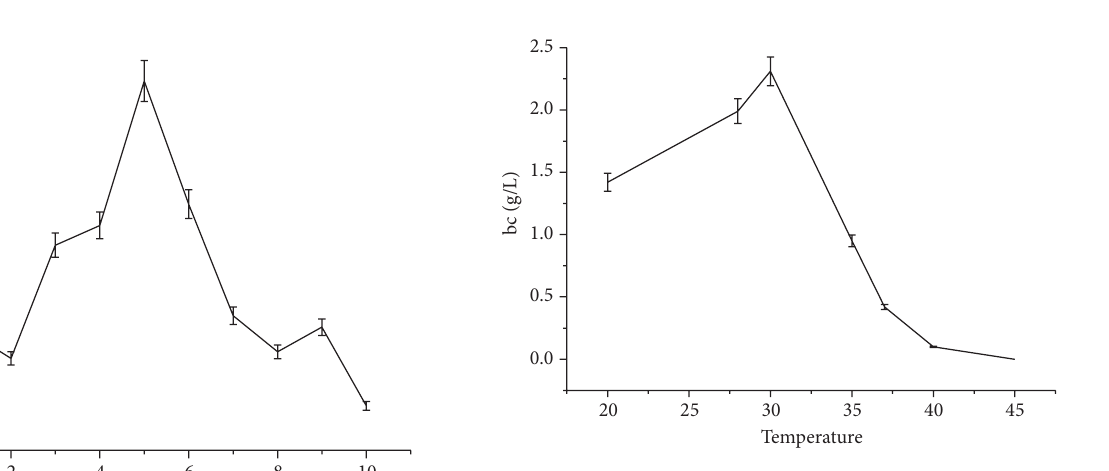
Figure 7: Effect of temperature on cellulose production by Glu- conacetobacter sp.